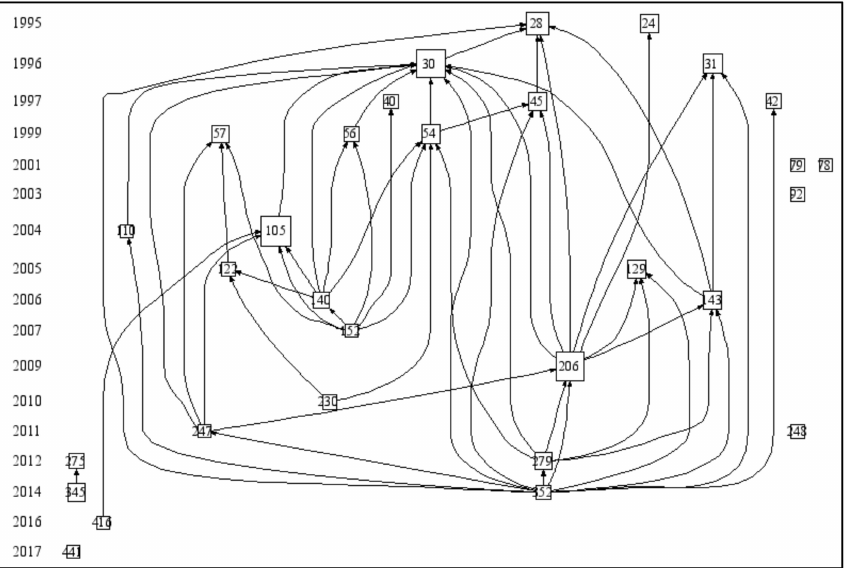
Figure 5. The citation (TLCS) analysis map of the top 30 publications on unfrozen water in frozen soils (UWFS) using HistCite Pro based on data retrieved from the Web of Science Core Collection. The left column is the year that corresponds to the node on the horizontal line. Each node represents a publication, and the number within represents the paper’s order in the database used for analysis in the HistCite Pro. The size of the node corresponds to the number of citations, while the arrows represent the citation’s relationship to other publications in the list; more arrows indicate more connectivity to other